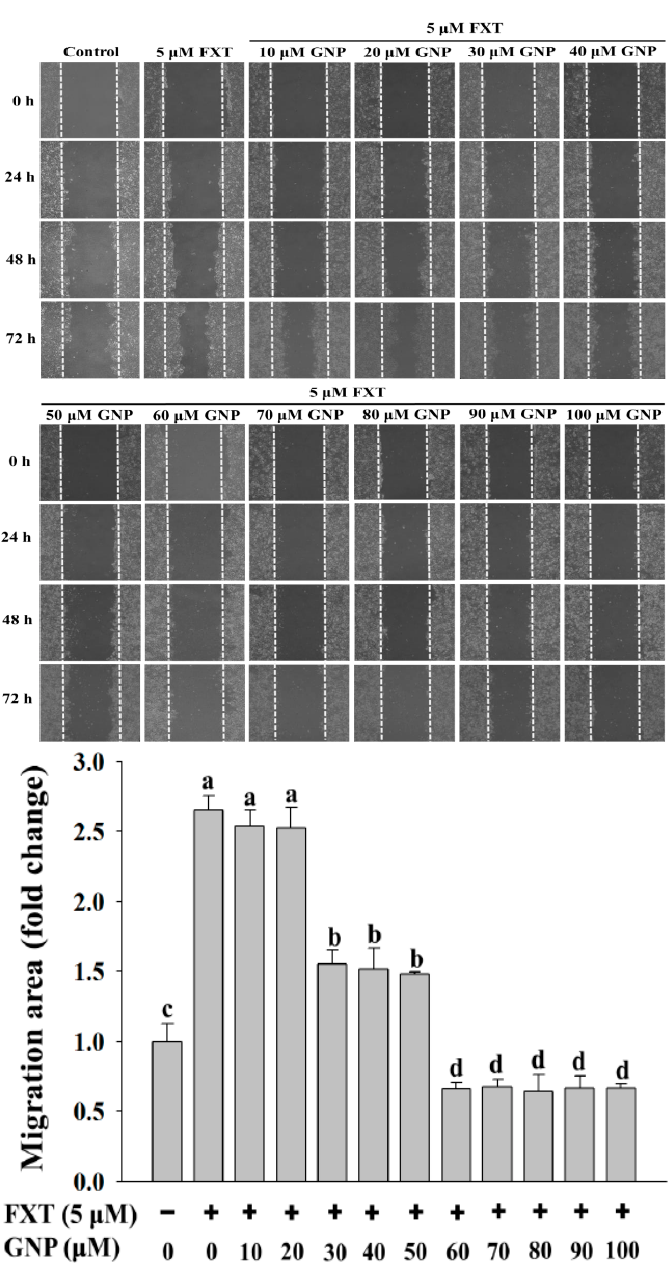
compared to control ( p < 0.05).